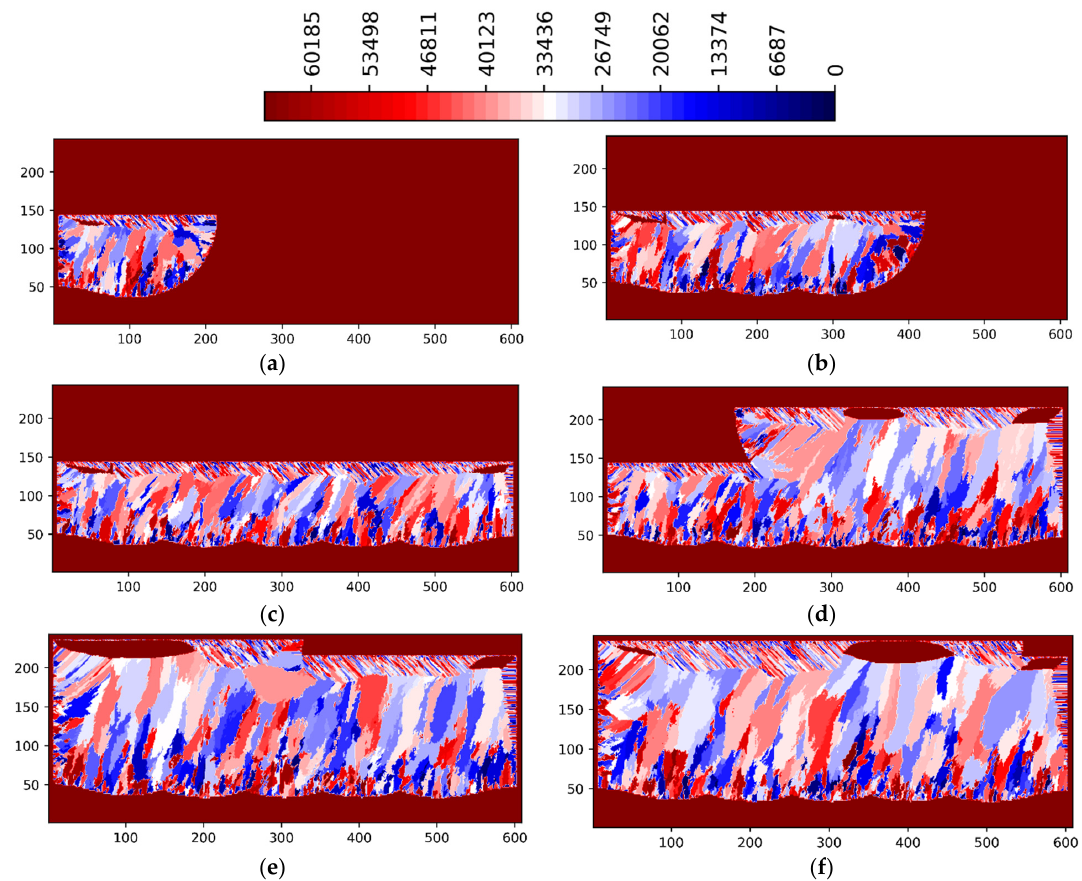
Figure 6. LPBF IN718 simulated grain structure (3 layers, 5 tracks)—ZX plane (P = 250 W): ( a ) layer 1 track 1; ( b ) layer 1 track 3; ( c ) layer 1 track 5; ( d ) layer 2 track 3; ( e ) layer 3 track 2; ( f ) layer 3 track 4.